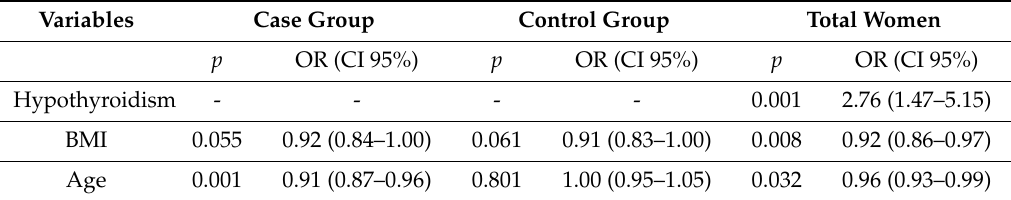
Table 3. Relationship between independent variables and PCS *.